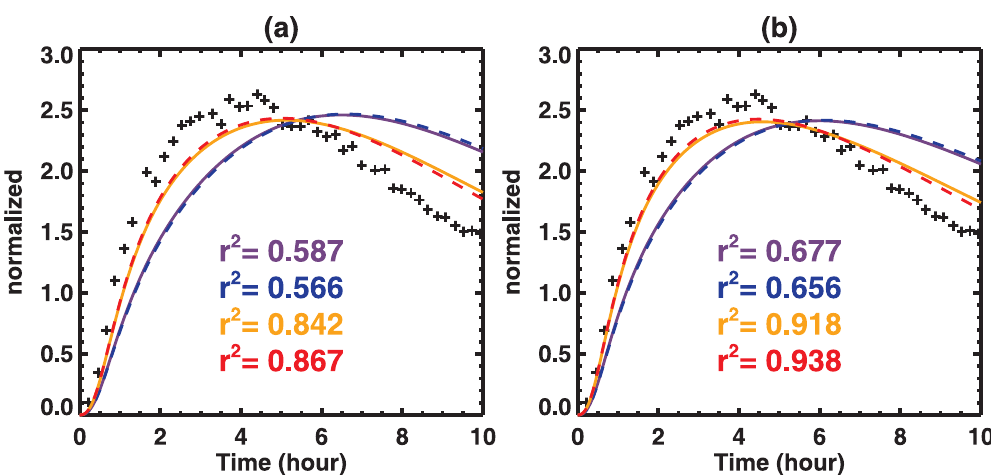
Fig. 6. Calculated mixing ratios of the normalized sum of MVKNO3 and isomers (HMVKANO3 and MACRNO3) in the experiment of Paulot et al. (2009). The reported measurements are shown as black crosses. The assumed OH-reaction rate of the isoprene β -hydroxy-nitrates is either (a) 1.3 × 10 − 11 (left) or (b) 2.2 × 10 − 11 cm 3 molec. − 1 s − 1 (right). The model runs further differ in the OH-reaction and photolysis rates of the carbonyl nitrates. Indigo and blue curves: MCM photolysis; orange and red: fast photolysis as described in this article. The OH-reaction rates are obtained either from the MCMv3.2 (full lines) or from Neeb (2000) (dashed lines). The (squared) Pearson correlation coefficients are also